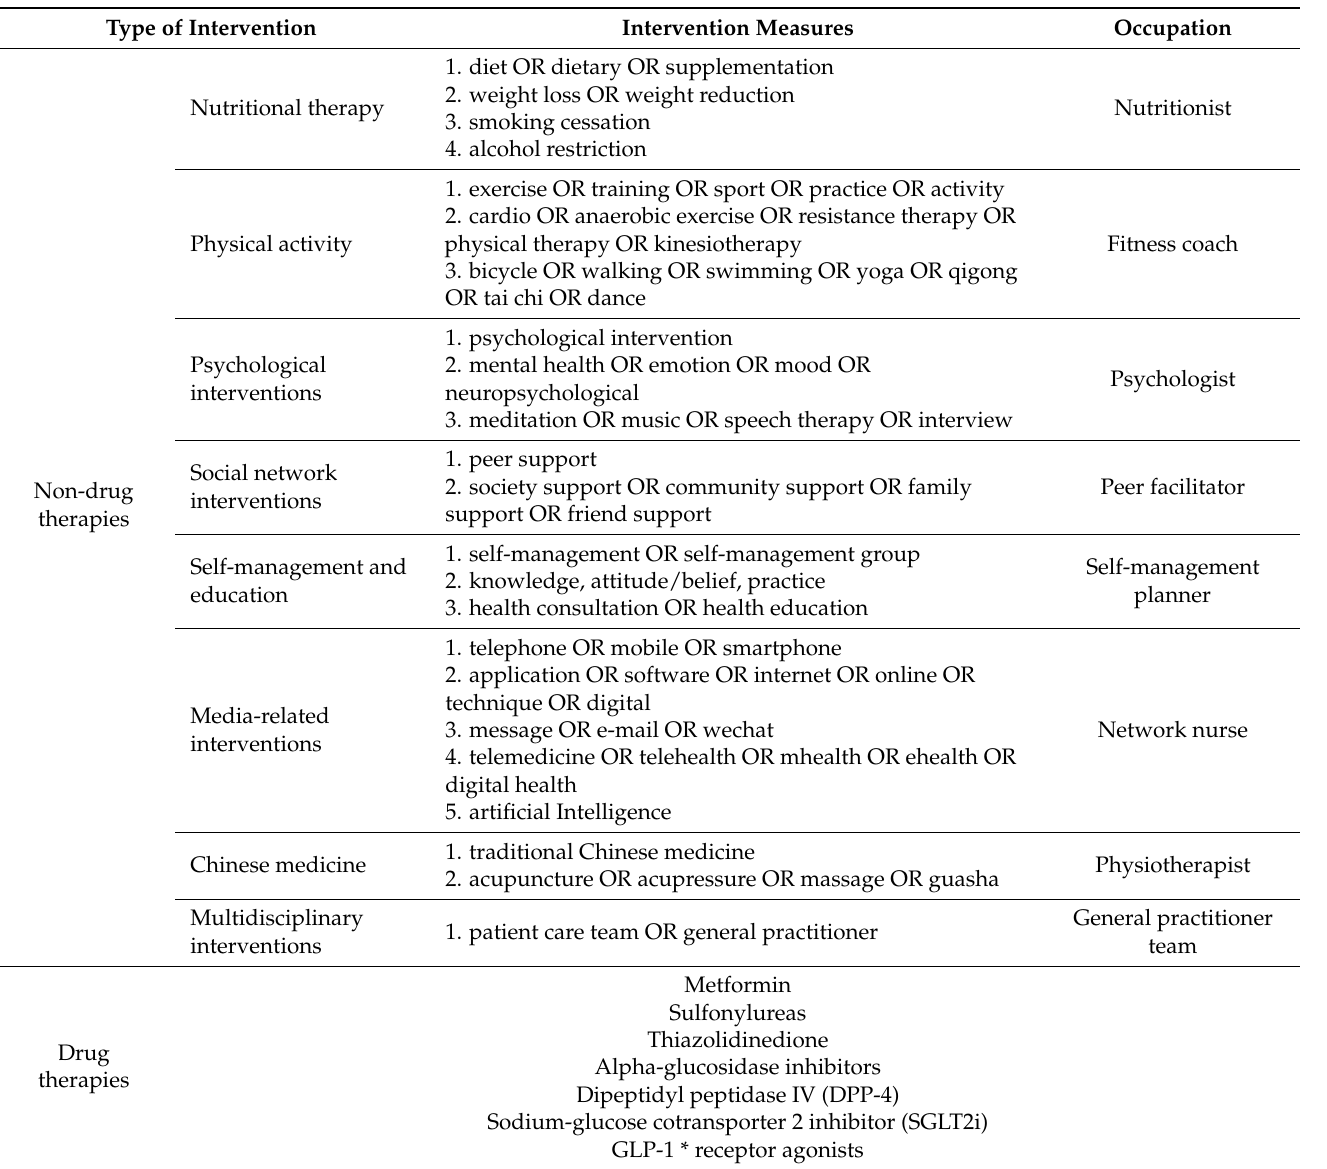
Table 1. Classification of